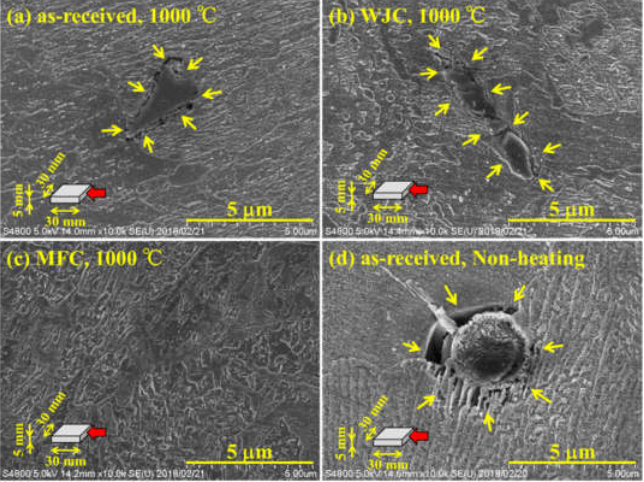
Figure 8. SEM images of the Cr–Mo steel (SCM 435) surface heated at 1000 ° C for 10 min.